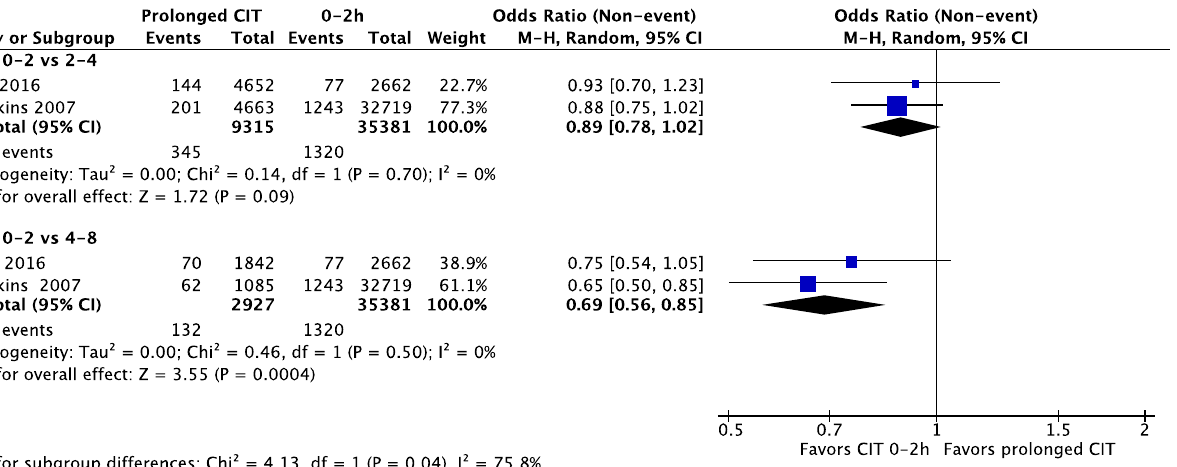
Figure 6. One-year graft survival; CIT of 0–2 h (reference) versus 2–4 and 4–8 h of CIT. CIT: cold ischaemia time.